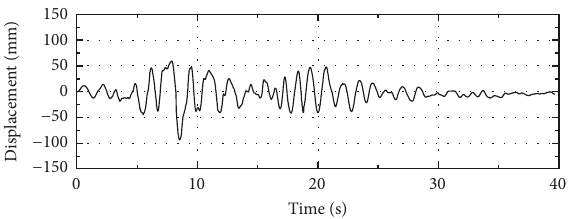
Figure 19: Displacement response curve of intensity 7 rarely of synthesized (longitudinal input).